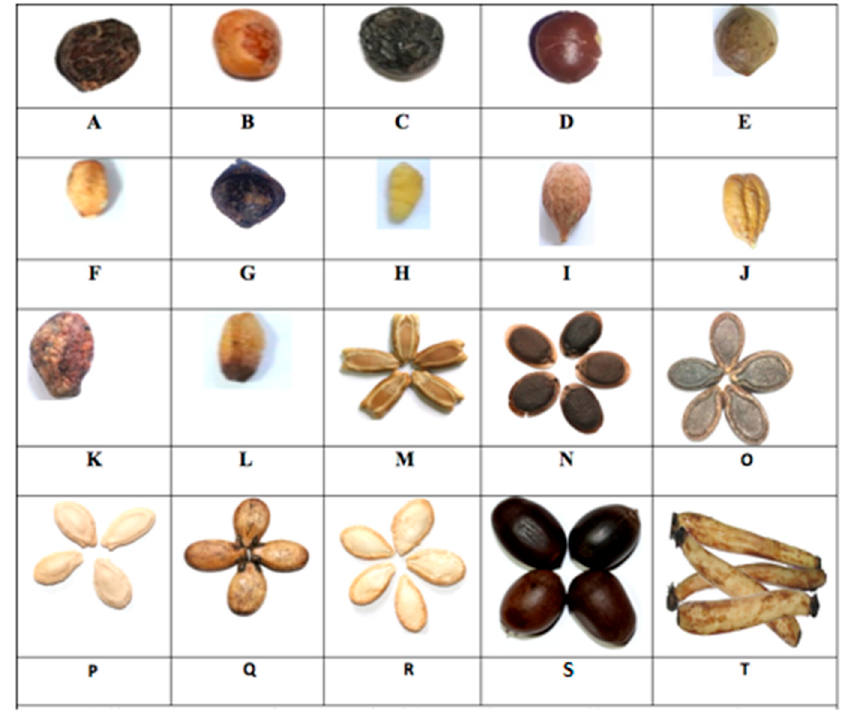
Figure 1. Seed images: ( A ) = B. Lanzan seed, ( B ) = B. Lanzan kernel, ( C ) = Z. mauritiana , ( D ) = Z. mauritiana , ( E ) = T. catappa seed, ( F ) = T. catappa kernel, ( G ) = T Arjuna seed, ( H ) = T Arjuna kernel, ( I ) = T. Bellirica seed, ( J ) = T. Bellirica kernel, ( K ) = T. Chebula seed, ( L ) = T. Chebula kernel, ( M ) = L. siceraria seed, ( N ) = L. aegyptiaca seed, ( O ) = P. fistulosus seed, ( P ) = B. hispida seed, ( Q ) = C. lanatus var. lanatus seed, ( R ) = C. maxima seed, ( S ) = N. nucifera seed, ( T ) = N. nucifera rhyzome.